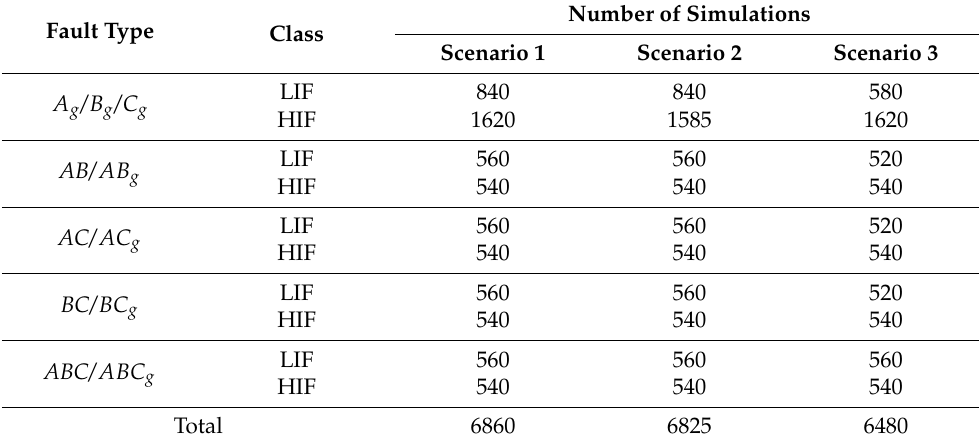
Table 8. Number of simulations per scenario and fault